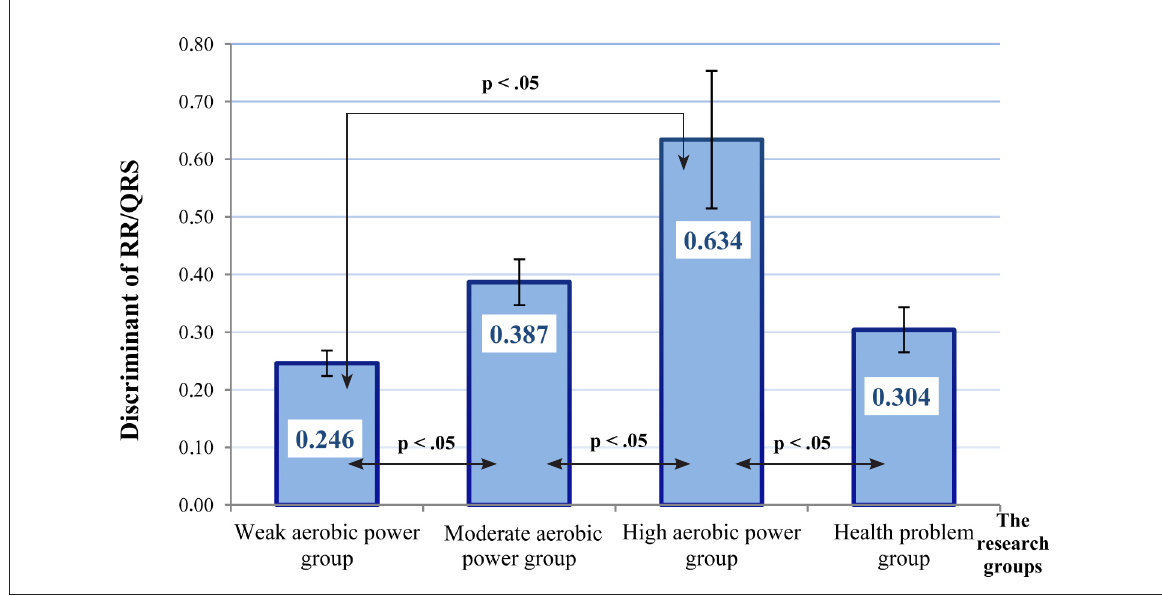
Note. p < .05 – statistical difference between groups. Figure 2. Discriminant of concatenation between RR and QRS parameters at the anaerobic threshold during bicycle